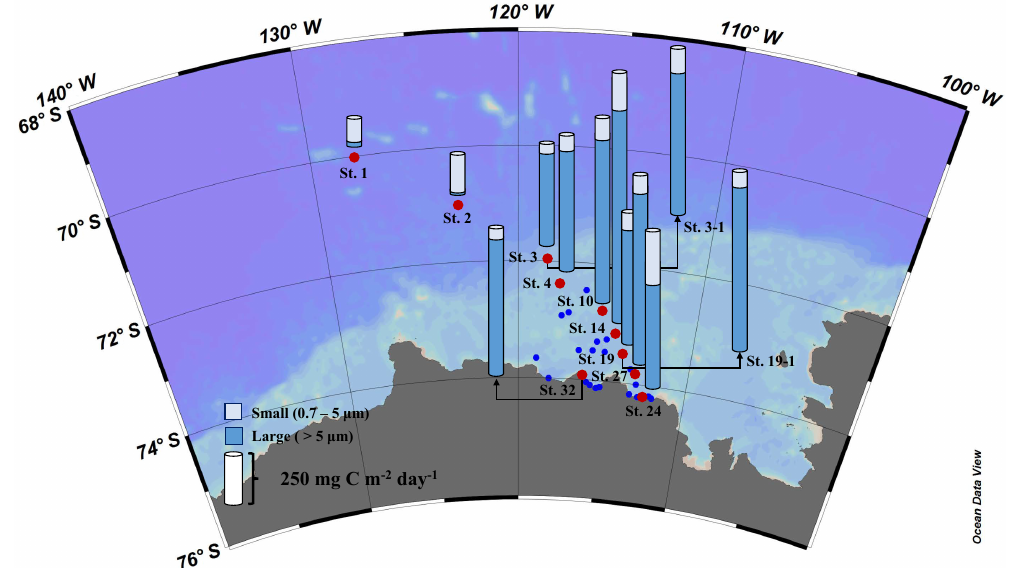
Figure 4. Water-column-integrated daily carbon uptake rates (mgCm − 2 d − 1 ) of small (0.7–5µm) and large (>5µm) phytoplankton.